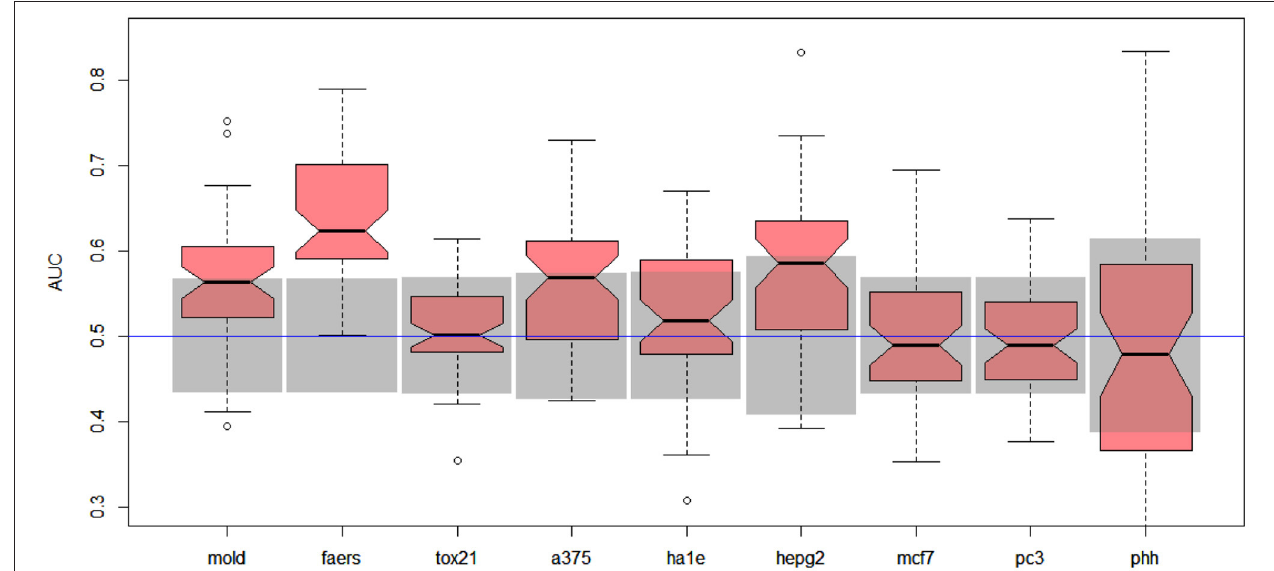
FIGURE 2 | Results for DILI1 decision (DILI severity 6 or above) on various data sets. Gray boxes correspond to 95% confidence interval for the null hypothesis. Predictions based on MOLD, FAERS, A375, and HEPG2 are better than random ones.